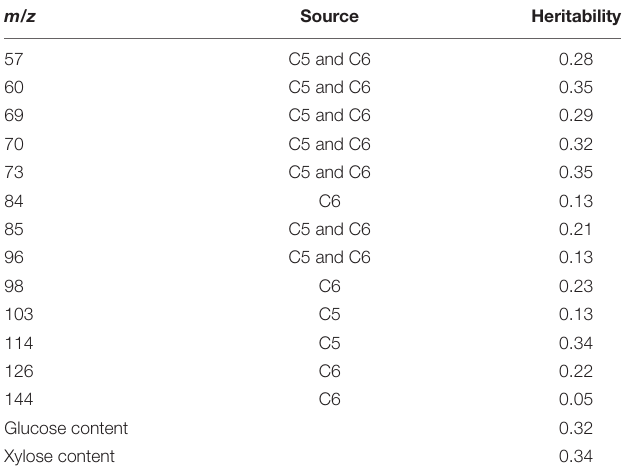
TABLE 4 | Broad-sense heritability of glucose and xylose contents and ions positively correlated with glucose and xylose contents and annotated based on the py-MBMS analysis of the P. trichocarpa pedigree set [heritability of ions and annotations summarized from Harman-Ware et al.